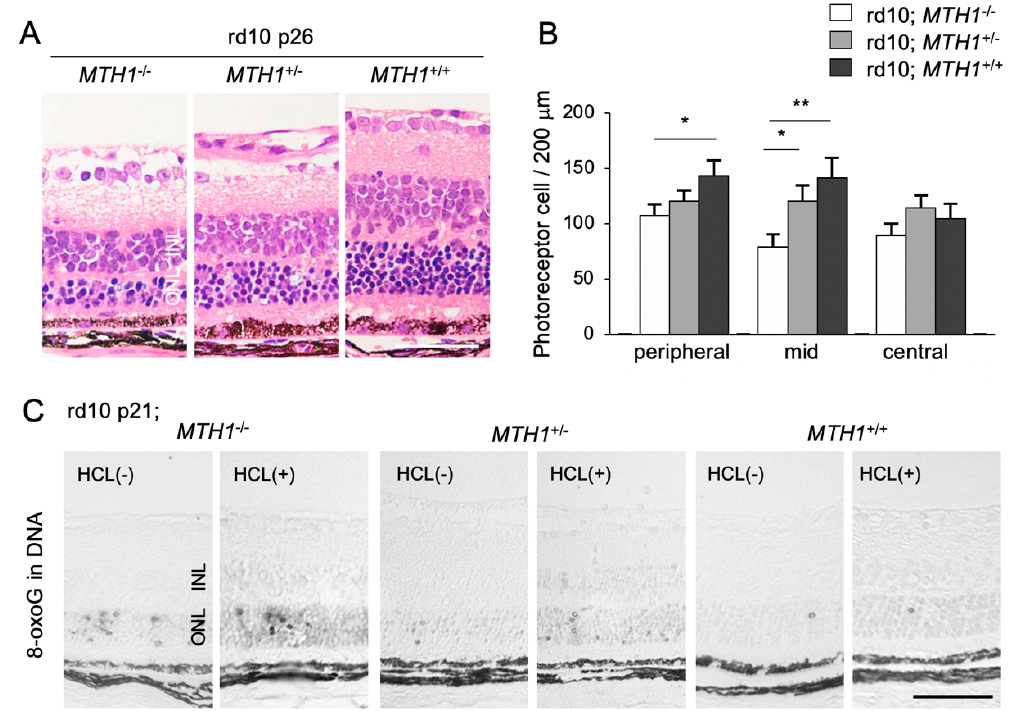
Figure 4. The Figure is reproduced from [16] with copyright permission. Transgenic overexpression of human Mut T homolog-1 attenuates oxidative DNA damage and suppresses retinal degeneration. ( A ) Histological examination of rd10 mice, rd10 mice with hemizygous human MutT homolog-1 ( hMTH1 ) expression (rd10; hMTH1-Tg +/ − ), or rd10 mice with homozygous hMTH1 expression (rd10; hMTH1-Tg +/+ ). Scale bar, 50 µ m. INL: inner nuclear layer. ONL: outer nuclear layer. ( B ) Quantitative analysis of the number of photoreceptor cells in the ONL. Note that transgenic overexpression of hMTH1 significantly suppresses photoreceptor cell loss in rd10 mice. ( C ) Immunohistochemical staining of 8-oxoG in the retina of rd10, rd10; hMTH1-Tg +/ − , or rd10; hMTH1-Tg +/+ mice. 8-oxo-G accumulation in rd10 mice is attenuated by transgenic hMTH1 expression. Scale bar, 50 µ m. * p < 0.05. ** p <